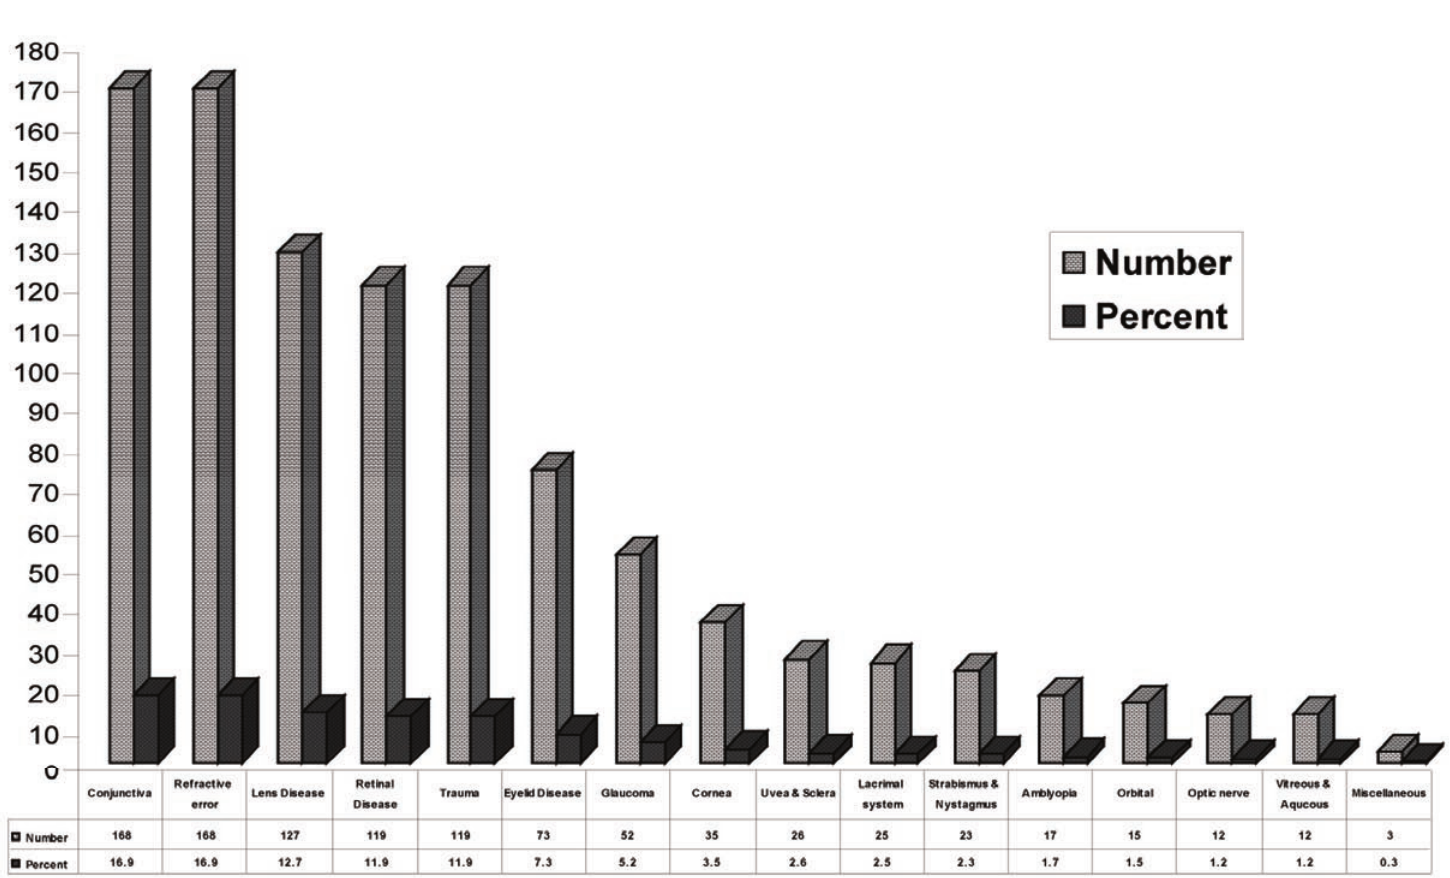
Figure 1 . The ocular disease frequency based on main group